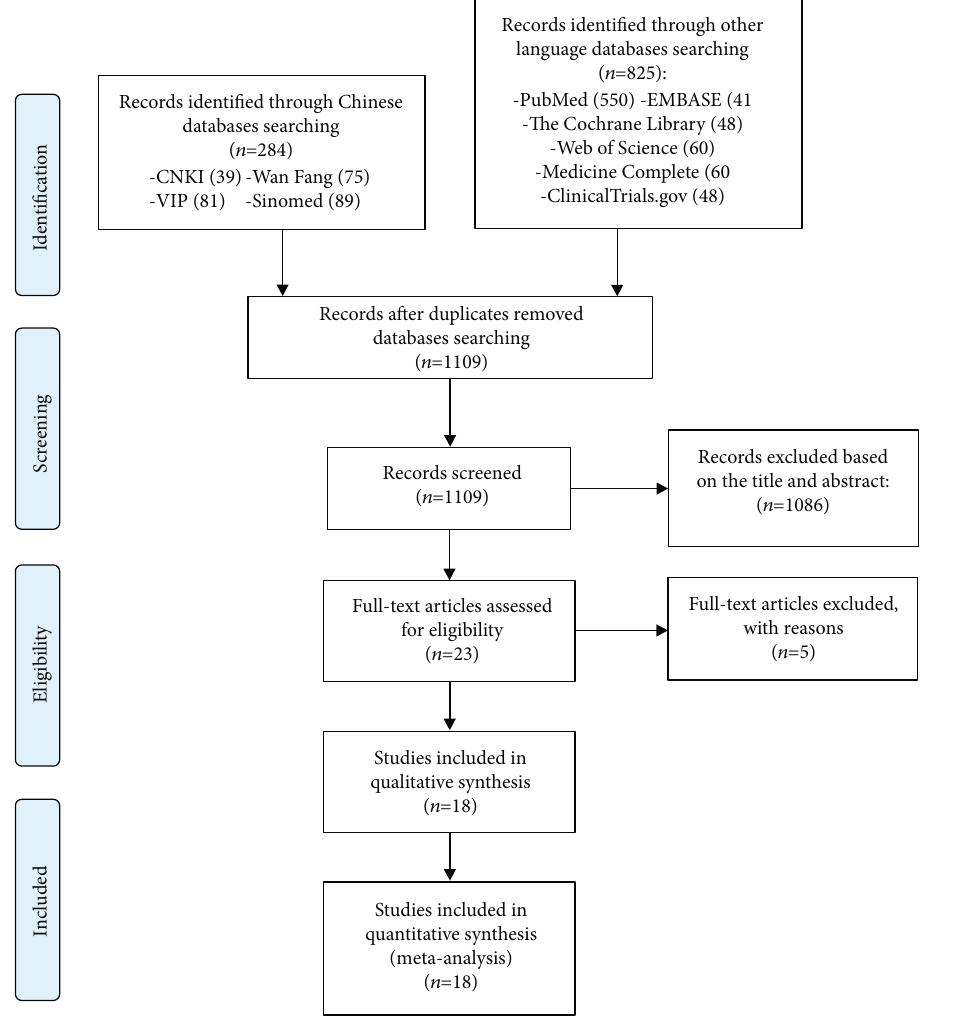
Figure 1: Flow diagram of research screening (CNKI: China National Knowledge